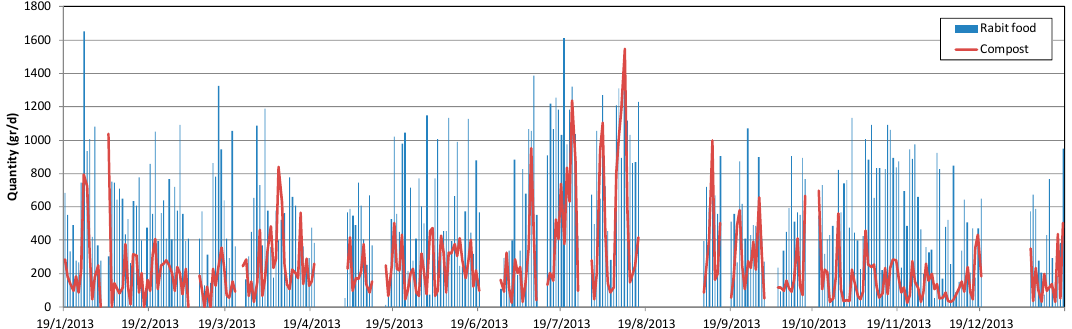
Figure 2. Daily variations of organic remains meant for rabbit food or composting.